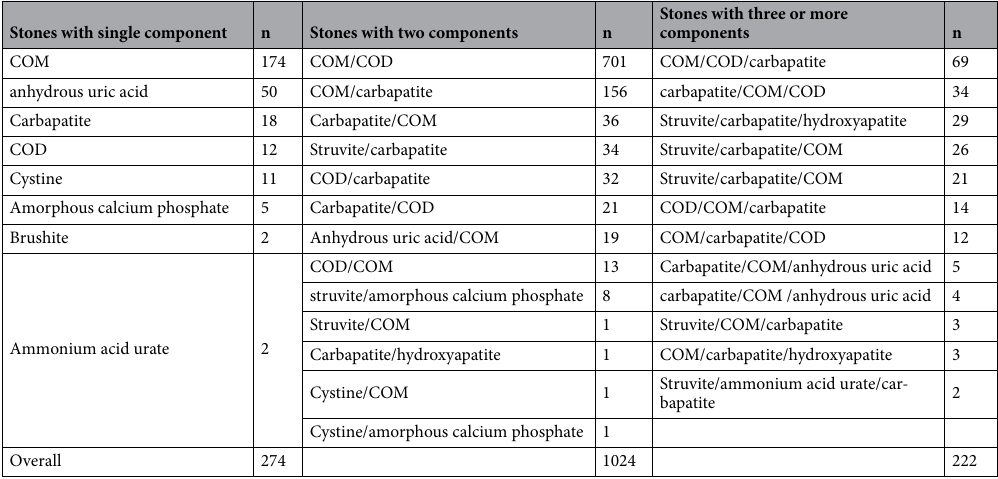
Stones with single component n Stones with two